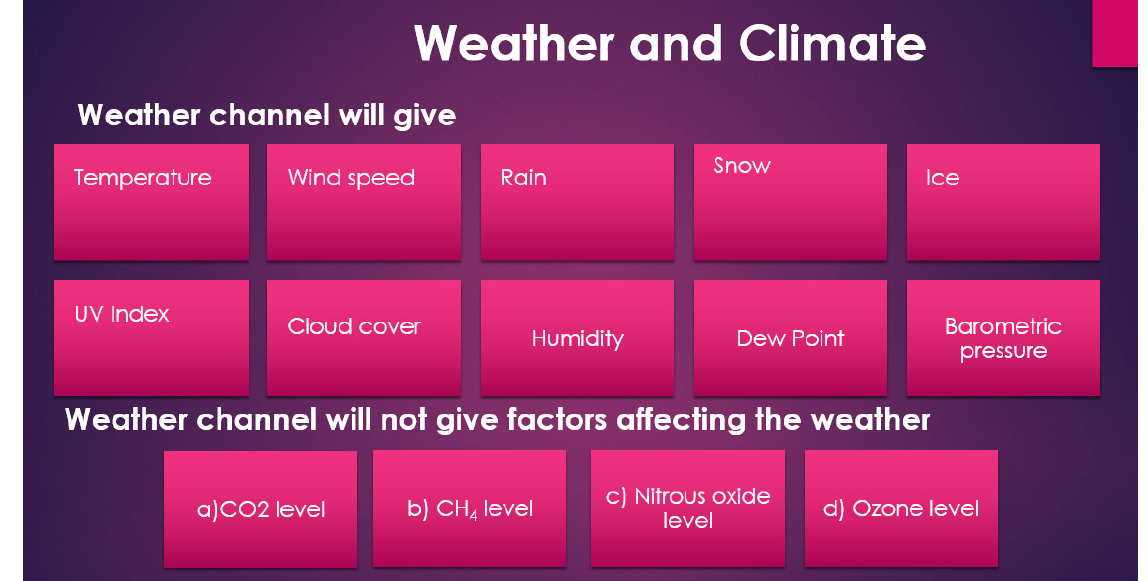
Figure 1 . The weather conditions. Figure 1. The weather